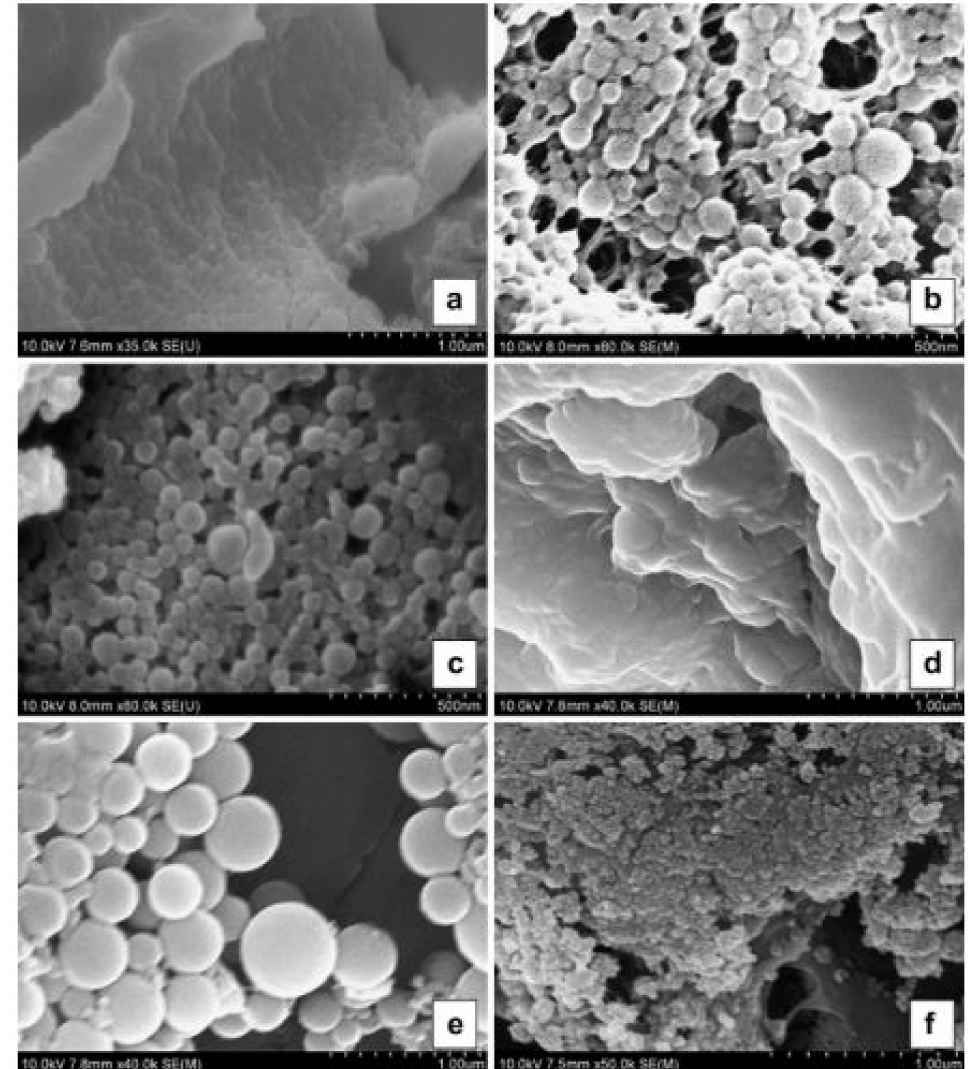
Figure 7. SEM images for samples encapsulating EOs under different pH conditions after lyophilizing. ( a – c ) encapsulated thymol under pH = 4, 6.5 and 10, respectively. ( d – f ) encapsulated carvacrol under pH = 4, 6.5 and 10, respectively. Reproduced with permission from [88], ELSEVIER,